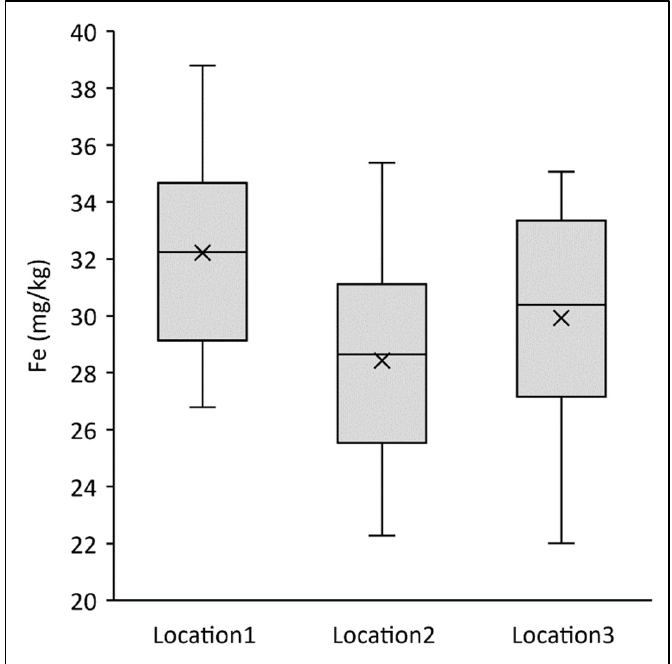
Figure 2. Fe content (mg/kg) in whole grain flours of 12 different varieties of common wheat grown at three different farmer locations (trial series 1).